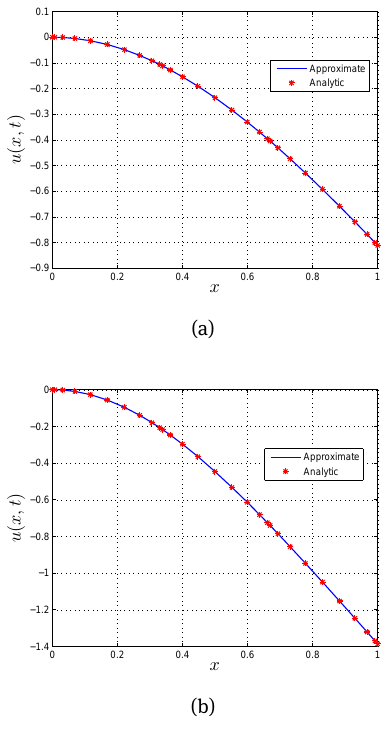
Figure 4: Analytical and approximate solution for example 3 at (a) t = 0.5 and (b) t = 1